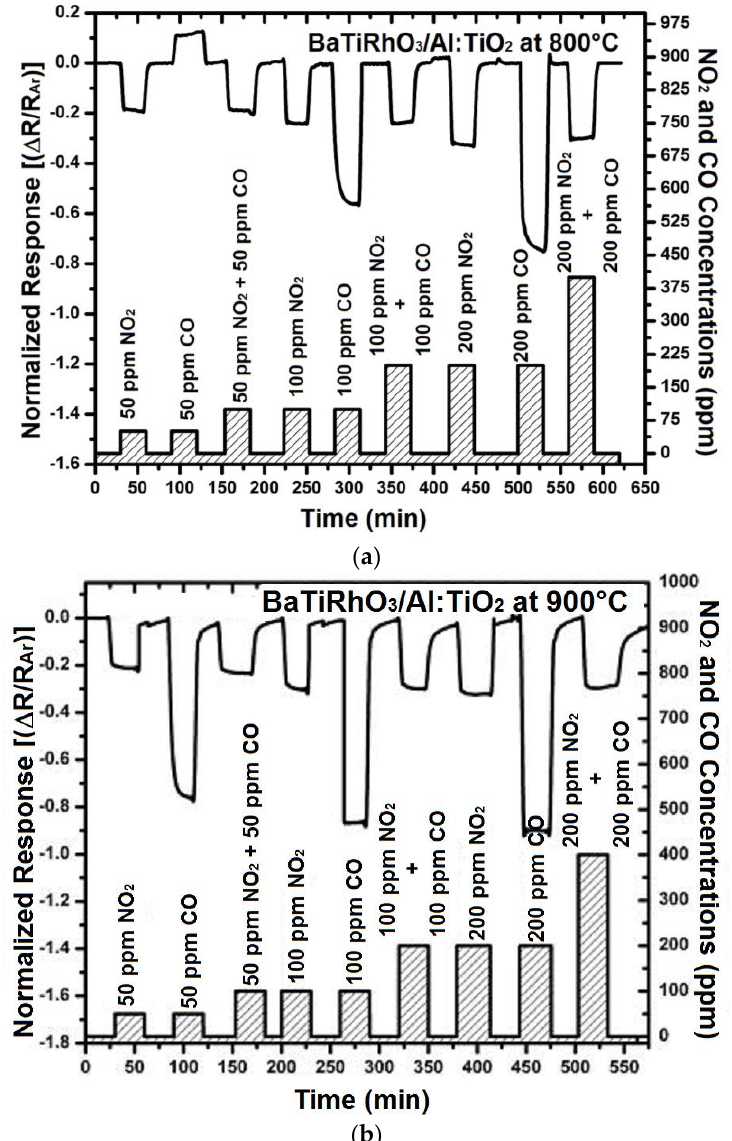
Figure 13. Sensor response of BaTi 0.95 Rh 0.05 O 3 catalyst + Al-doped TiO 2 duplex layers at 800 °C ( a ) and 900 °C ( b ) in dry argon environment on exposure to NO 2 and CO single and/or NO 2 + CO gas mixtures.